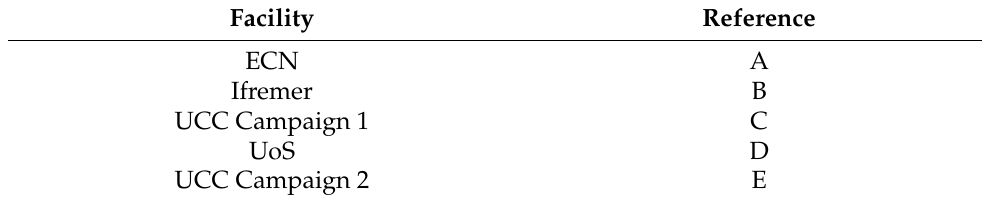
Table 1. List of test